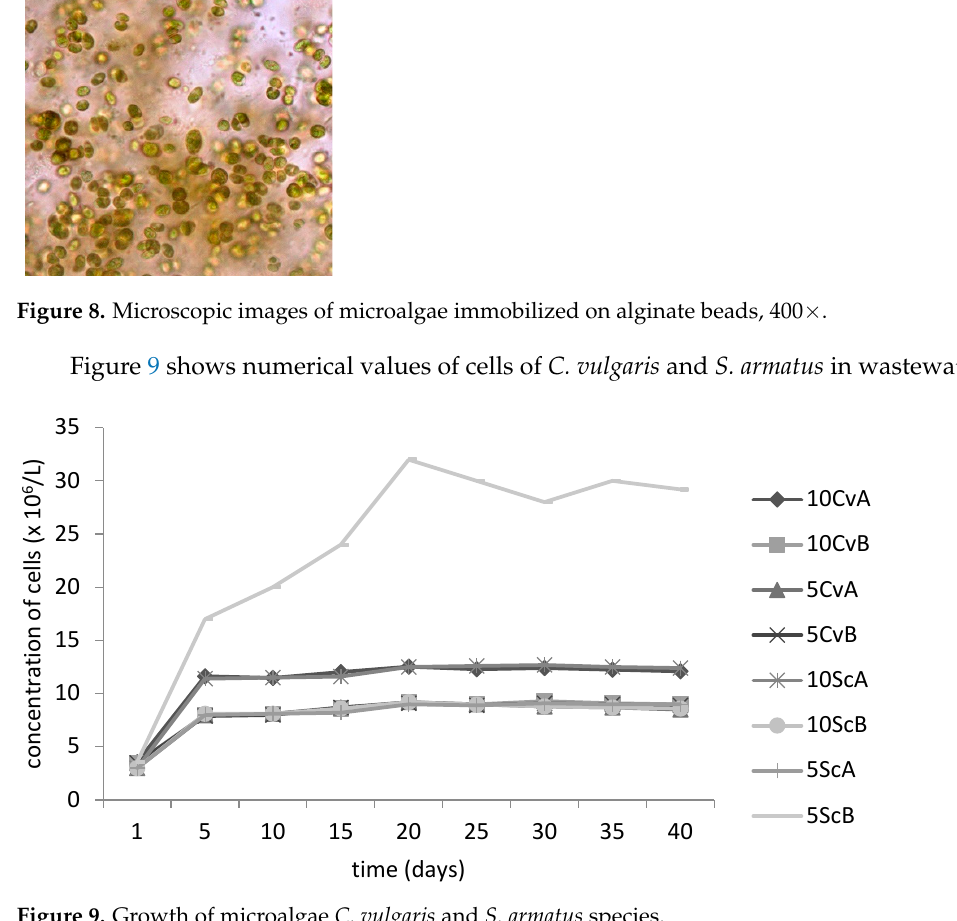
Figure 9. Growth of microalgae C. vulgaris and S. armatus species. Biomass concentration increased gradually. A higher increase in biomass concentra- tion was observed at the lower initial concentration of S. armatus biomass in the sample with microalgae 5ScB, compared to the samples where the initial biomass concentration was higher. The calculated results of the microalgal growth rate are shown in Table 1. Suspended microalgae showed higher biomass growth than when immobilized on alginate